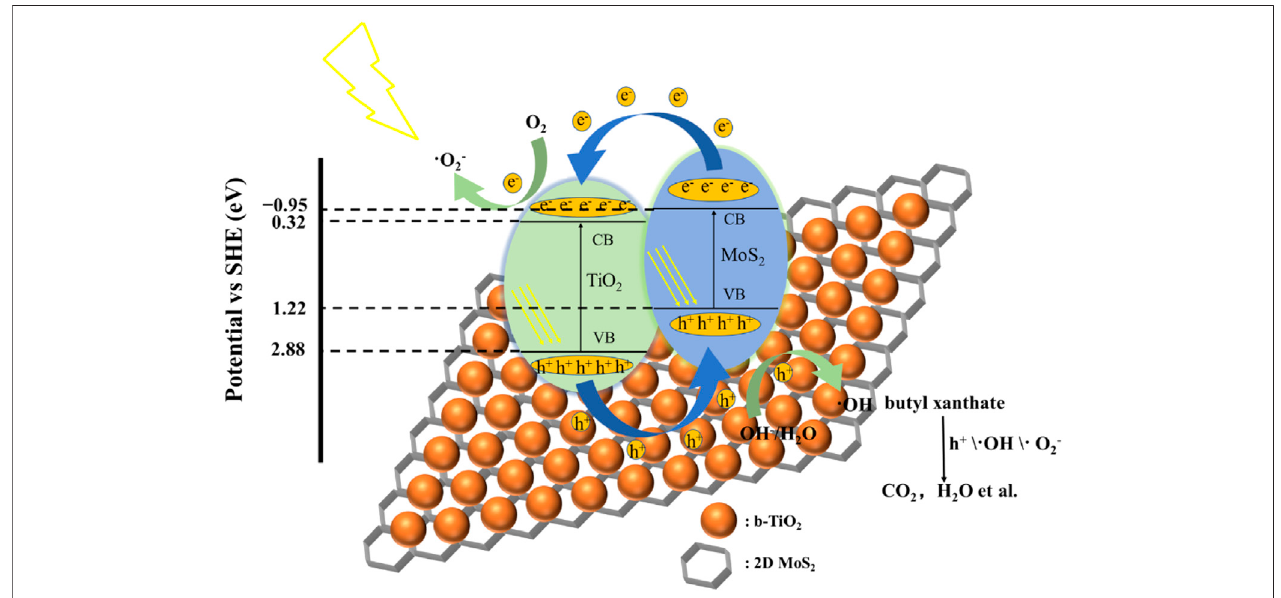
FIGURE 6 | Photocatalytic mechanism diagram of b-TiO 2 @MoS 2 photocatalysts. Adapted from Tang et al. (2022b). Copyright © 2022 Elsevier B.V.